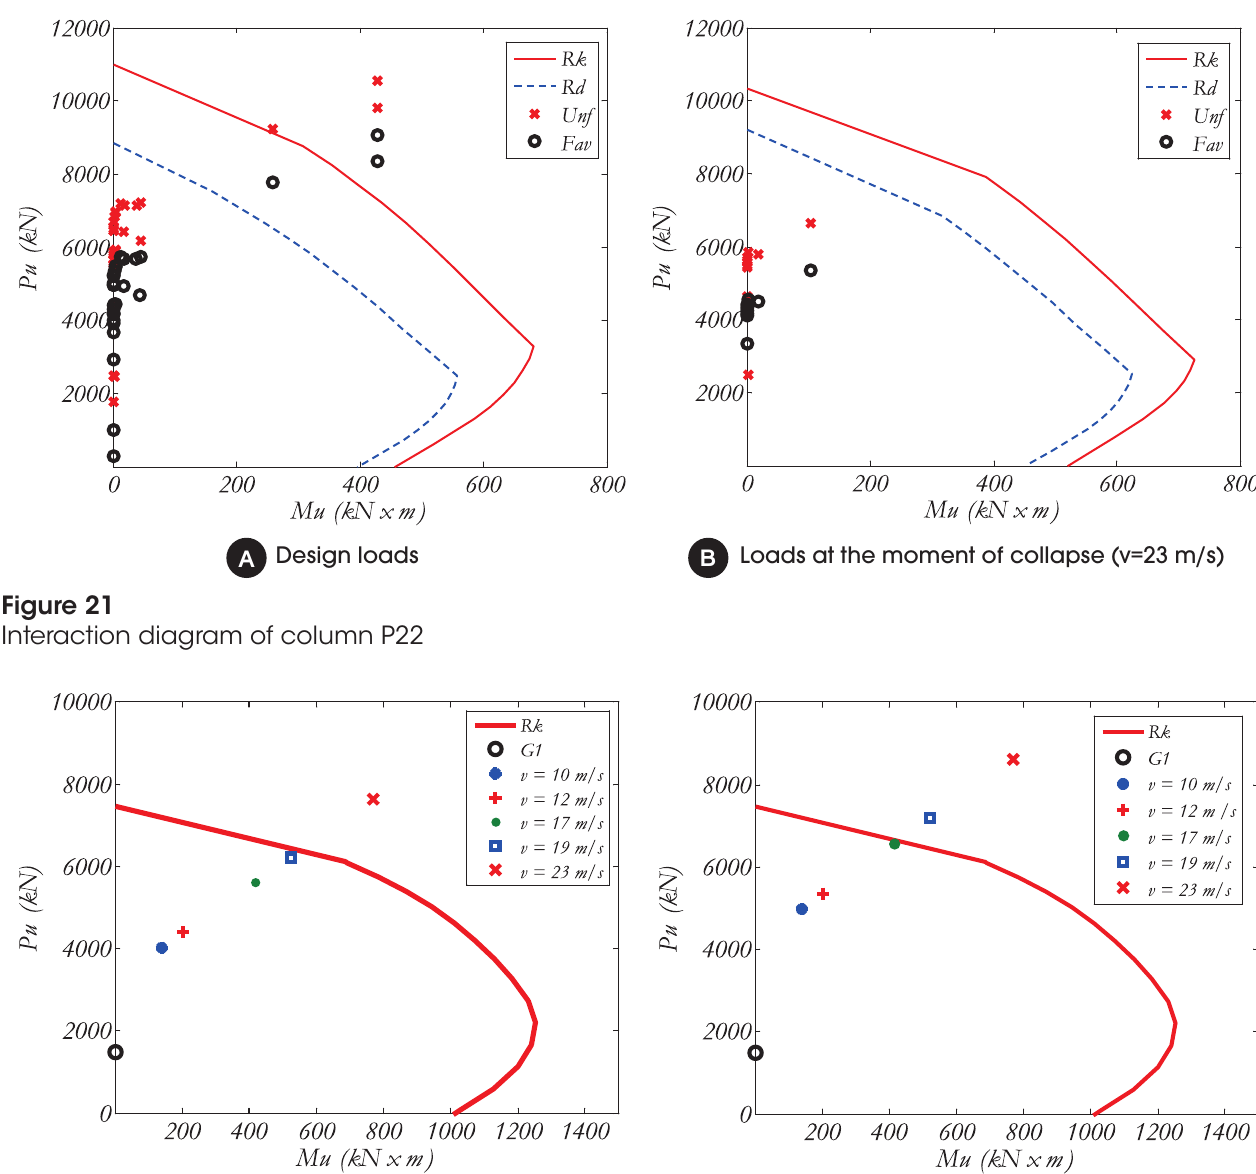
A Favourable combination B Unfavourable